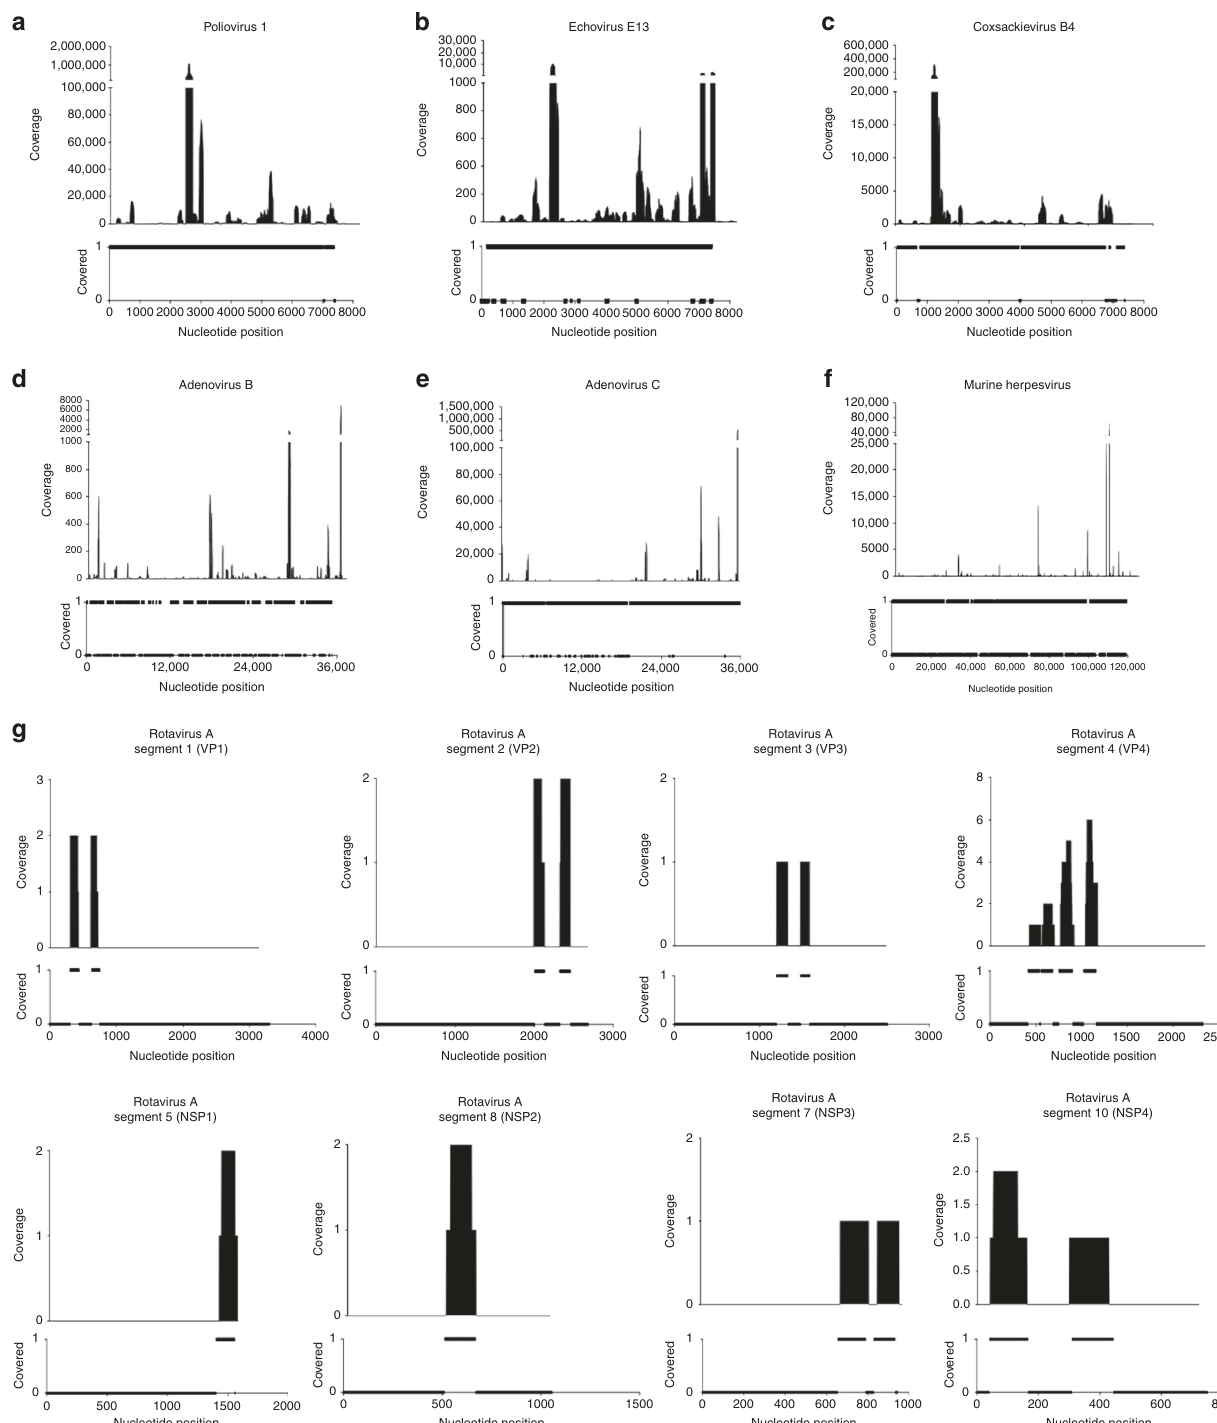
Fig. 2 Viral Mock Community (VMC) calculated genome coverage depth and span from remapping source reads to VirMAP reconstructed genomes. The VMC consists of puri fi ed preparations of seven different viruses ( a ) human poliovirus type 1 [strain Mahoney], ( b ) echovirus E13 [strain Del Carmen], ( c ) coxsackievirus B4 [strain Tuscany], ( d ) human adenovirus ( b , e ) human adenovirus ( c , f ) murine gammaherpesvirus 4, and ( g ) rotavirus, combined at different concentrations in phosphate-buffered saline. Coverage depth and span are represented for each of the viruses in VMC per nucleotide position. For coverage span, a value of 1 represents a nucleotide position covered with respect to the source genome. VMC is available at BioProject ID PRJNA431646